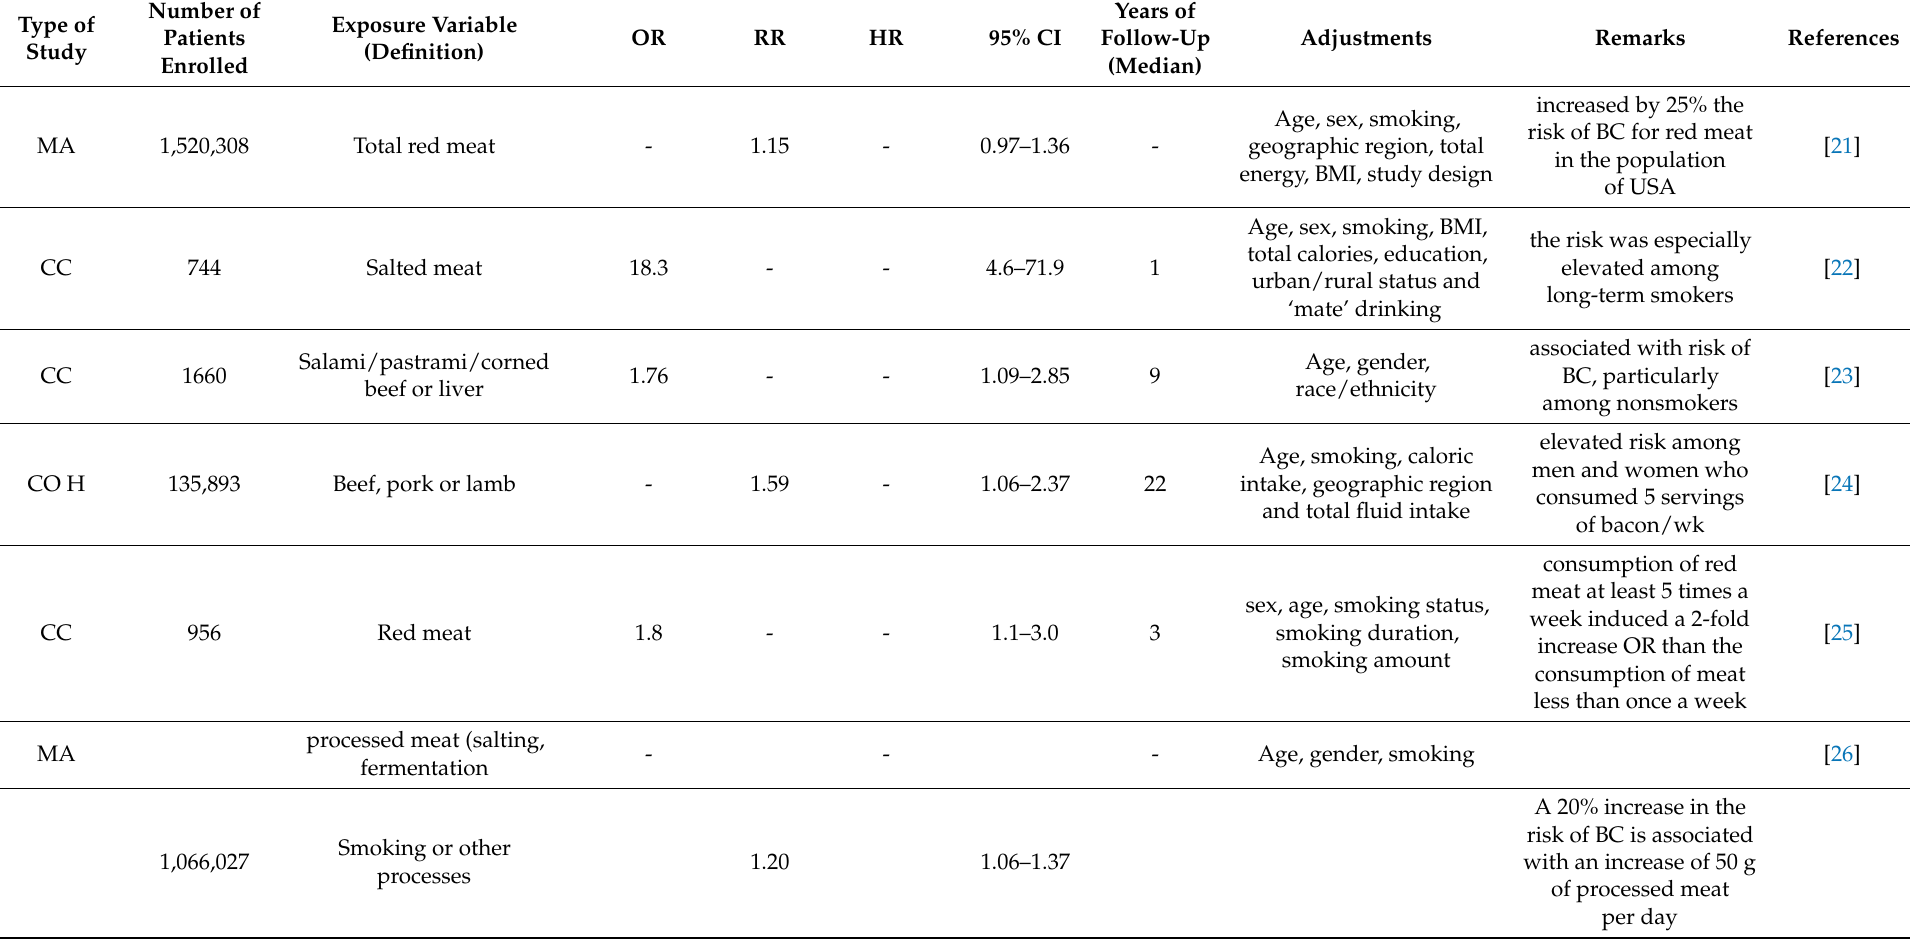
Table 1. Characteristics of studies that analyzed red meat or processed meat consumption and bladder